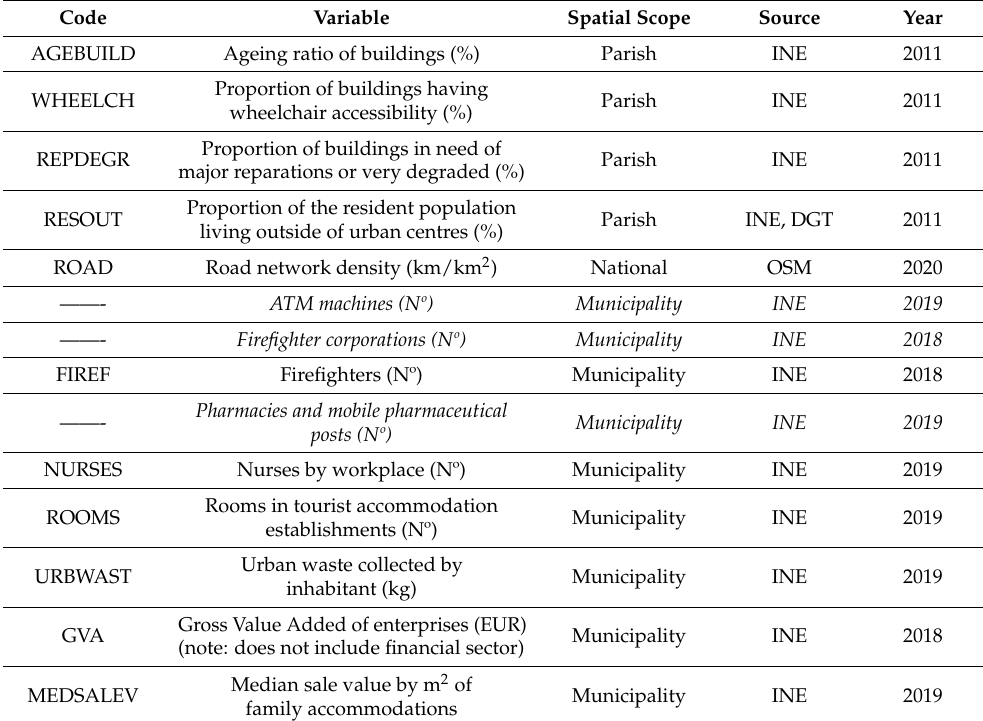
Table 3. The set of 14 variables used as input in the PCA for defining support capability. Variables in italic were not selected for the extracted principal components. INE—Statistics Portugal; DGT—Directorate- General of the Territory; OSM—Open Street